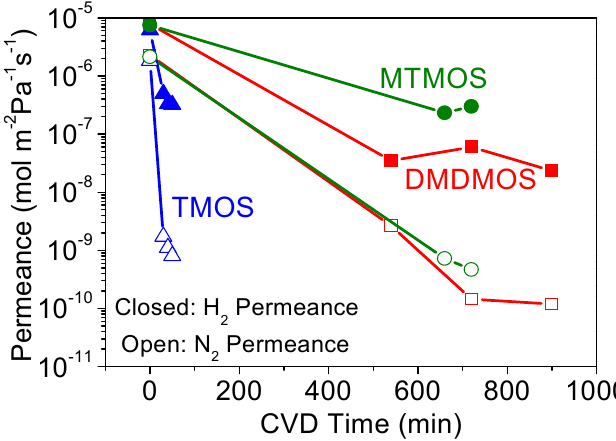
Figure 5. Changes in H 2 (closed symbols) and N 2 (open symbols) permeances during CVD at 650 °C of tetramethyl orthosilicate (TMOS), MTMOS, and dimethyldimethoxysilane (DMDMOS) precursors.